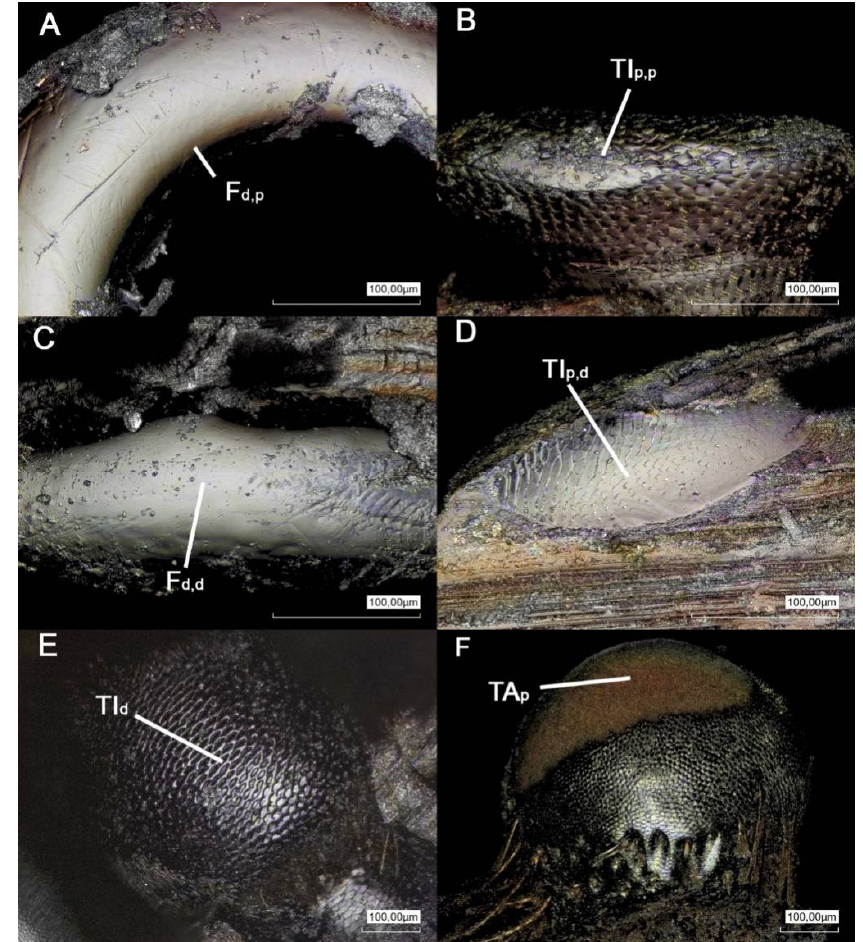
Figure 2. Confocal laser scanning microscopy images of the contacting surfaces in ( A – D ) the femur–tibia and ( E , F ) the tibia–tarsus leg joints of P. marginata . F d,p : the distal end of the femur, the proximal condyle; TI p,p : the proximal end of the tibia, the proximal condyle; F d,d : the distal end of the femur, the distal condyle; TI p,d : the proximal end of the tibia, the distal condyle; TI d : the distal end and the condyle of the tibia; TA p : the proximal end and the condyle of the tarsus.